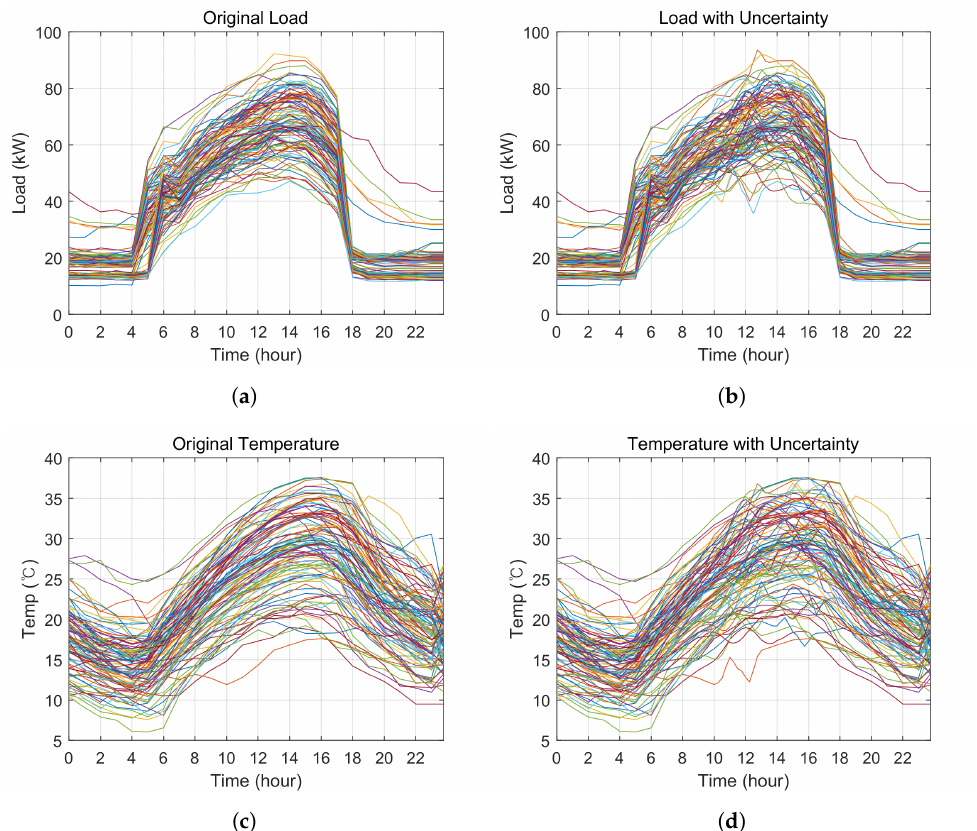
Figure 7. Original data and data with synthetic uncertainties. ( a ) Original load data, ( b ) Load with uncertainty data, ( c ) Original temperature data, ( d ) Temperature data with